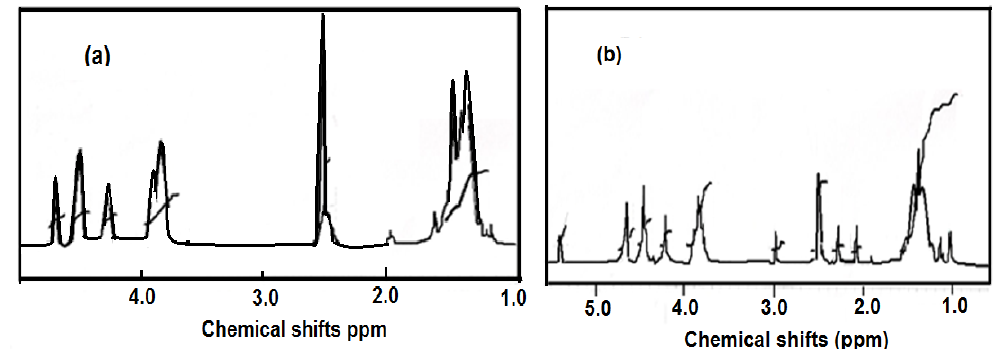
Figure 2. 1 H-NMR Spectra of ( a ) PVA and ( b )